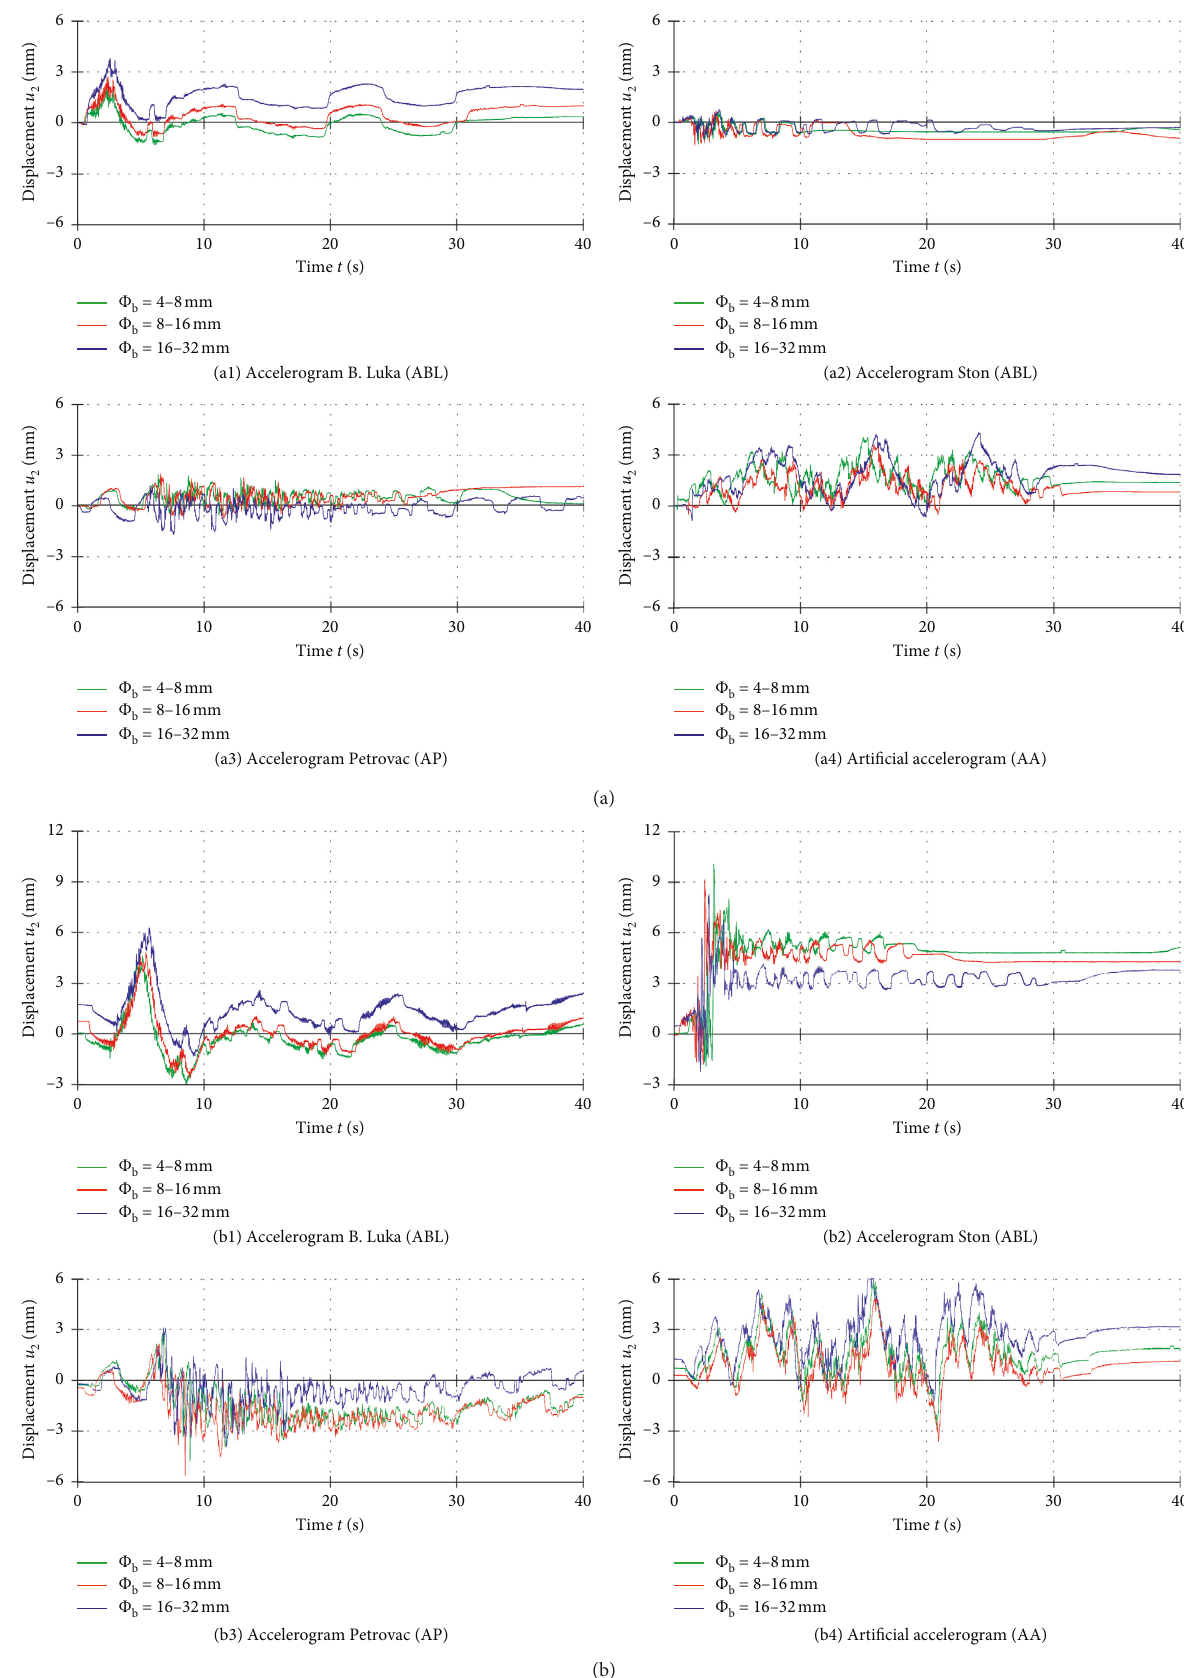
Figure 14: The effect of pebble fraction on horizontal displacement u